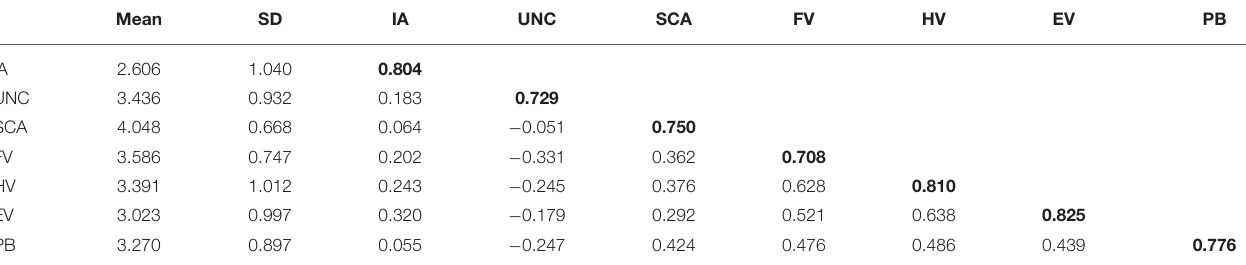
TABLE 4 | Means, standard deviations and correlations of variables.